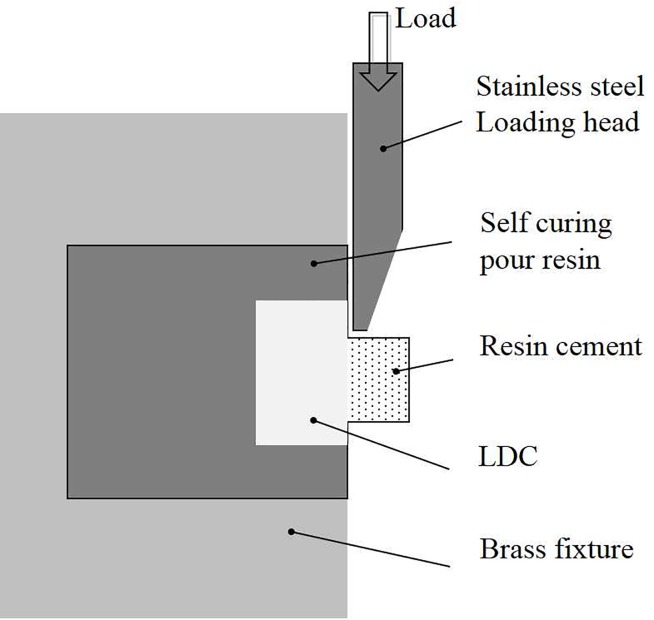
Schematic illustration of the shear bond strength test.